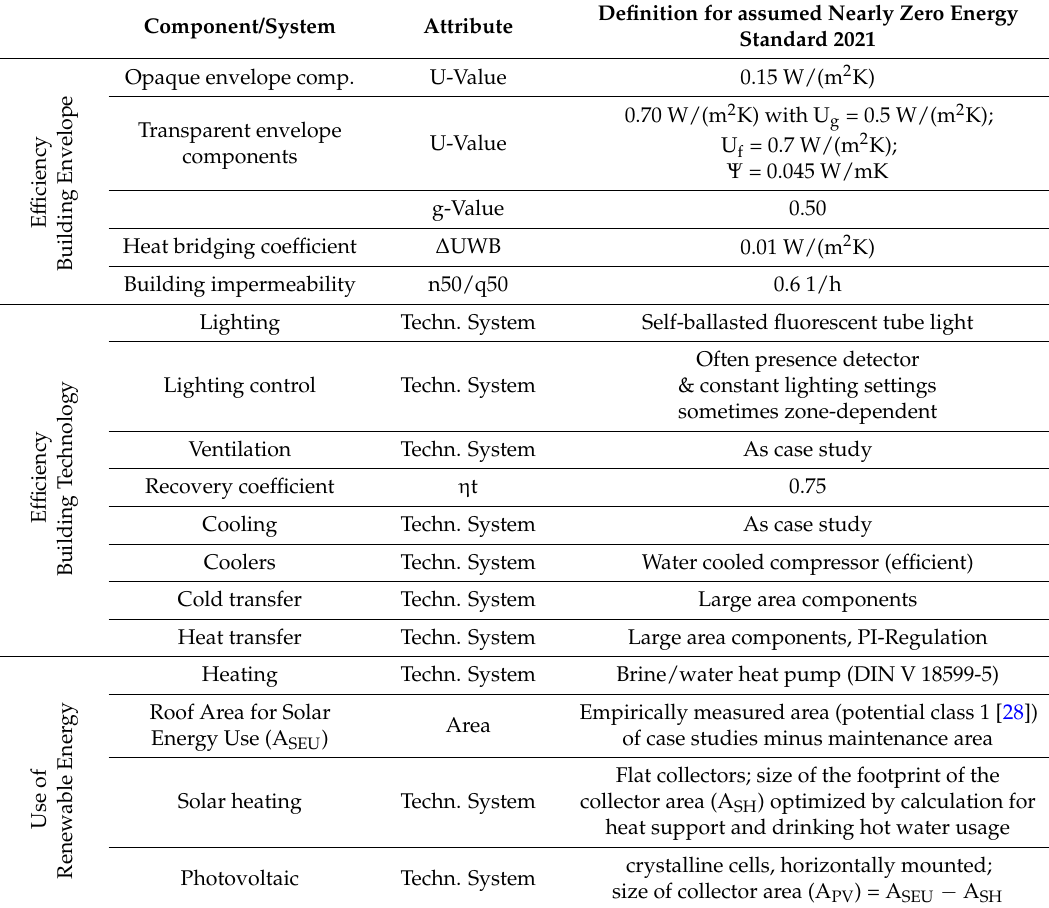
Table 4. Assumed Nearly Zero Energy Standard for 2021 (for climate class Cfb according to